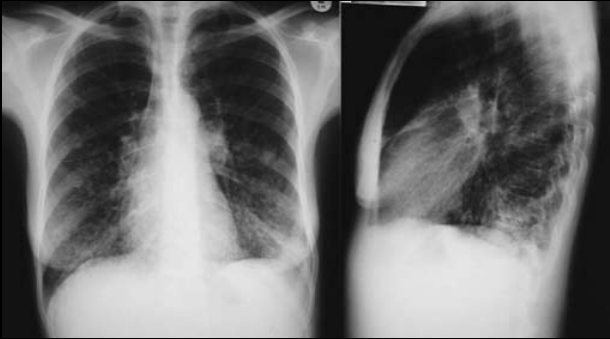
Fig. 1. Frontal and lateral chest radiographs in an adult female patient demonstrate bilateral basal reticulo-nodular infiltrate with areas of coalescence in both lower lobes, and lingula resulting in areas of sub- segmental consolidation. Hilar adenopathy is present.